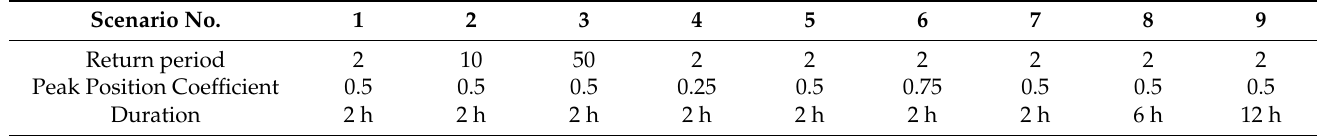
Table 2. Scenarios with different rainfall patterns.